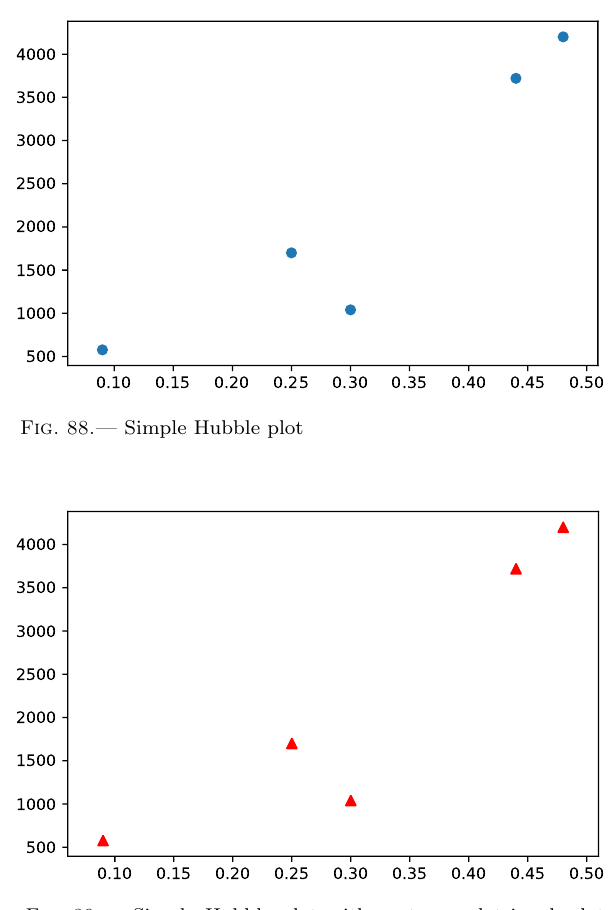
Fig. 89.— Simple Hubble plot with custom red triangle data points